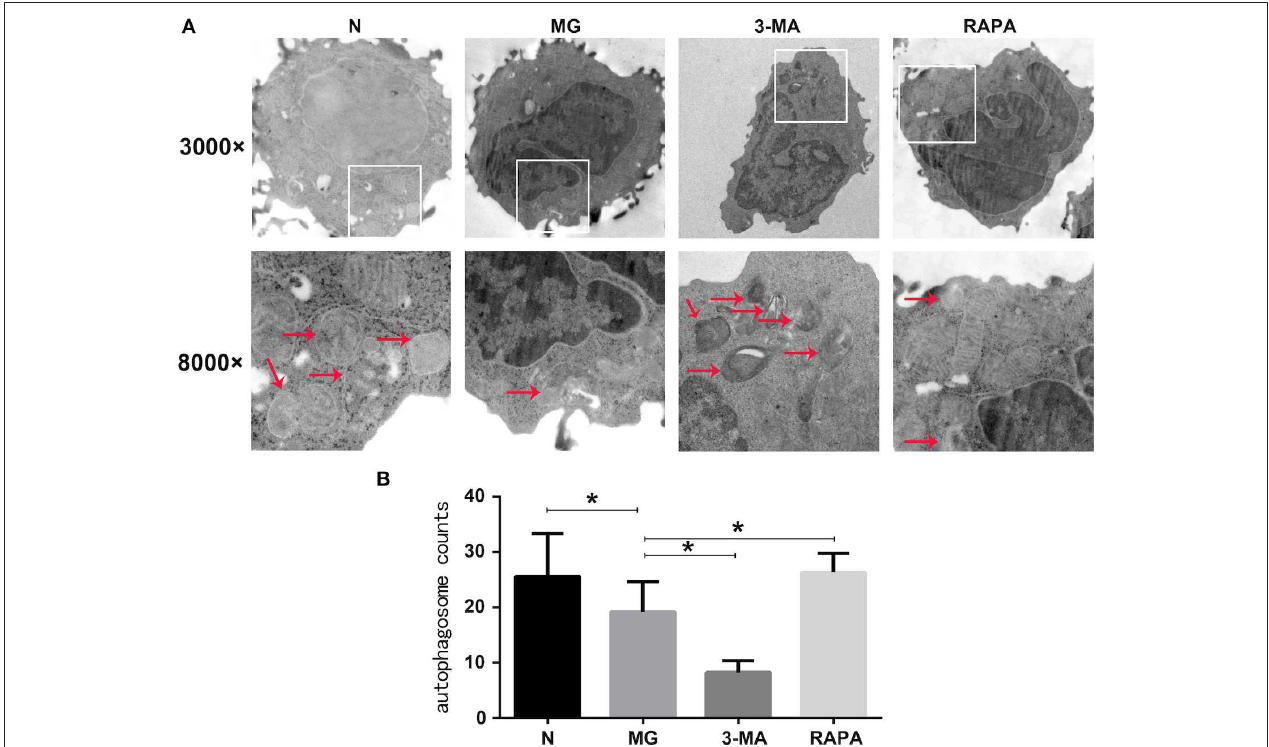
FIGURE 1 | Mitophagy under electron microscopy. (A) Mitophagy of healthy control group (N), myasthenia gravis (MG), 3-methyladenine treatment group (3-MA), and rapamycin treatment group (Rapa). In the first row is 3000 × , the second row is 8000 × . (B) N, MG, Rapa, and 3-MA four groups of statistical analyses (* P < 0.05).